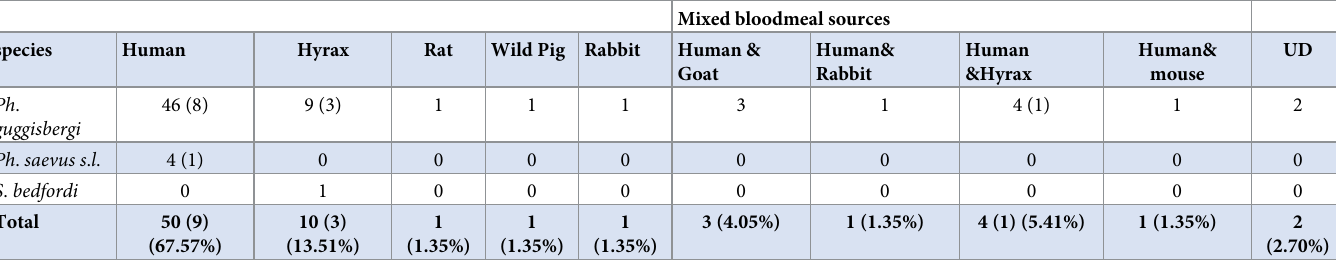
Table 2. Bloodmeal sources of female sandflies identified by real-time PCR-HRM analysis of CYT-B .